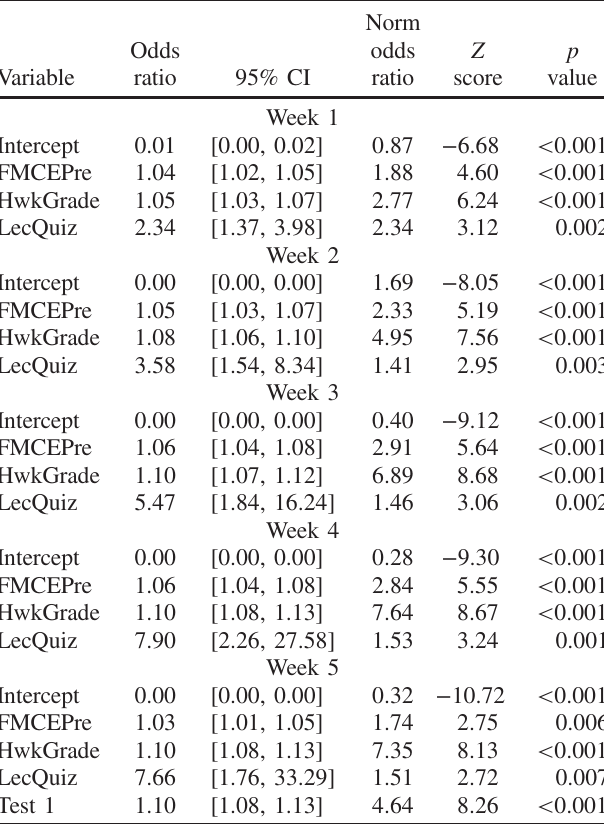
TABLE V. Physics 1: Logistic models in-class variables